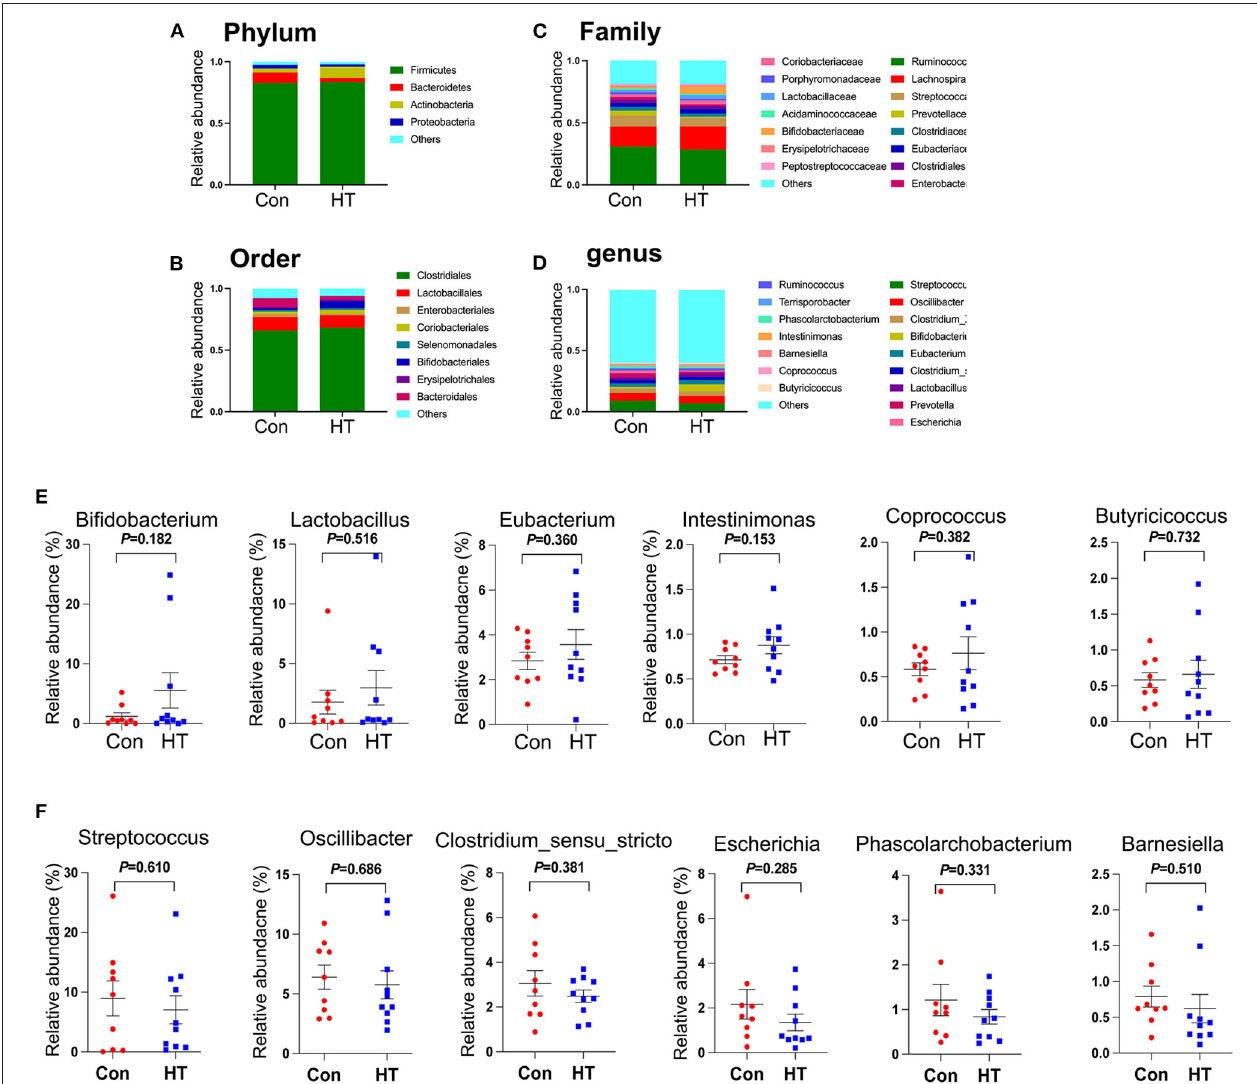
FIGURE 3 | Effects of HT on the fecal microbial composition. (A) The relative amount of microbiota in feces at Phylum level. (B) The relative amount of microbiota in feces at Order level. (C) The relative amount of microbiota in feces at Family level. The relative amount of microbiota in feces at Genus level (D–F) . Data were expressed as the mean ±